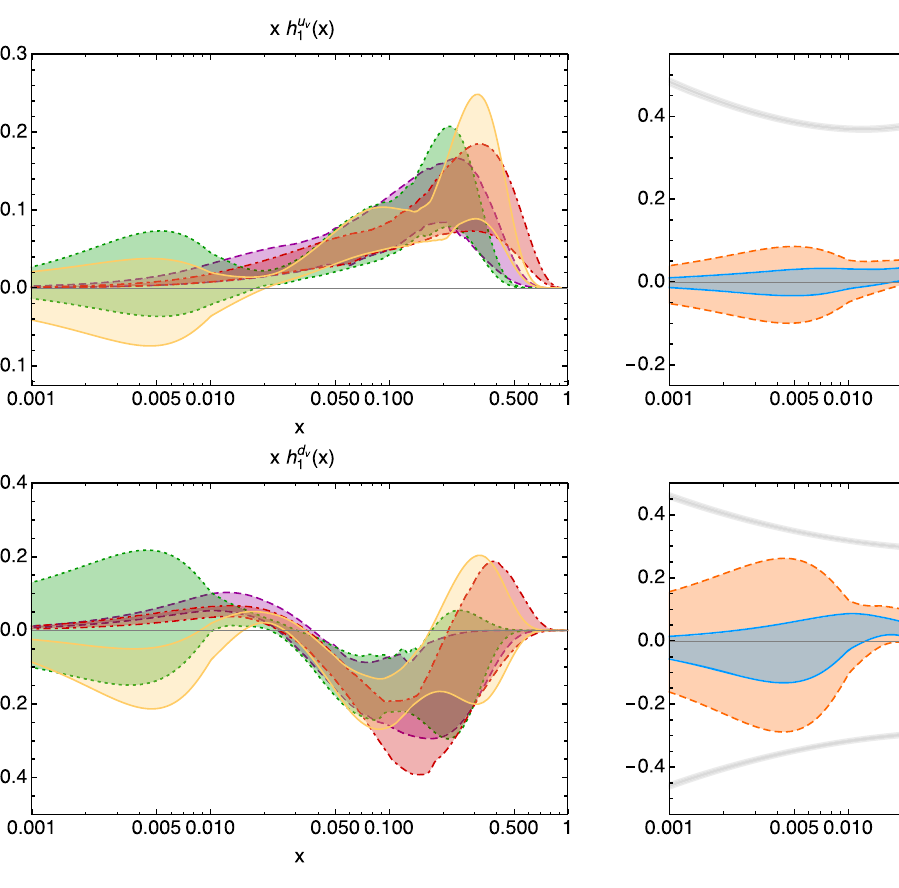
Fig. 5 Valence transversities for the up (upper) and the down (lower) at 68% in blue (with full blue line contour) and 95% in orange (with dashed contours) for the present fit. The gray bands represent the Soffer bound at NLO, here using JAM and MSTW08 at